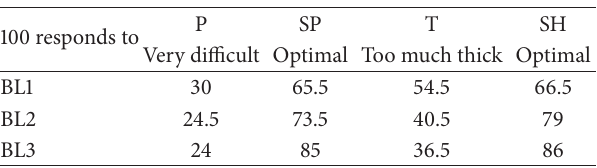
Table 5: Results of the sensory analysis, selected parameters (mean values, evaluated at scale 0–100).